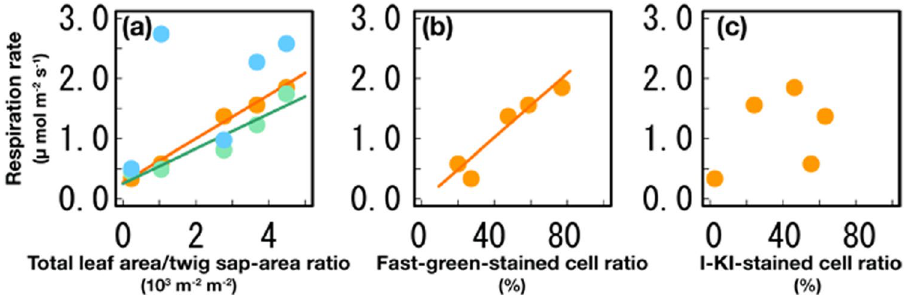
Figure 3. Respiration rates per unit surface area in the living trees. ( a ) Branchlets (6 mm in diameter; orange color), middle stem (20 mm in diameter; green color) and stem base (blue color). ( b ) Correlations between the ratios of the number of cells stained with fast-green to the total parenchyma cells and the respiration rates in the branchlets. ( c ) Correlations between the ratios of the number of cells with starch granules to the total parenchyma cells and the respiration rates in the branchlets. Ordinary least-squares linear regression lines were only drawn for statistically significant results ( α = 0.05) (we lost data in one living